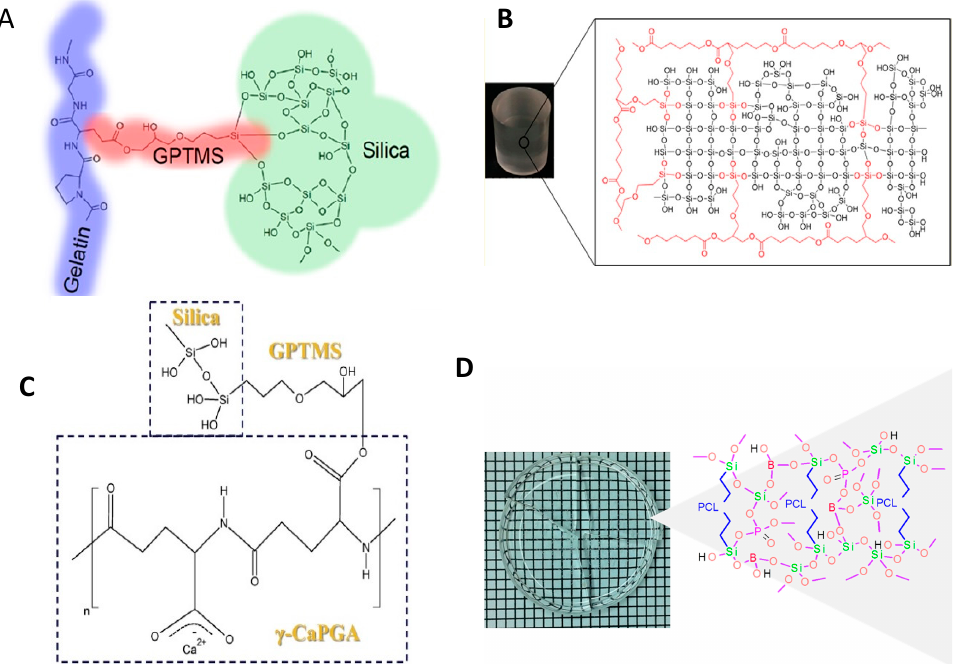
Figure 1. ( A ) Chemical structure of the linkage of organic and inorganic components by (3-glycidoxypropyl) trimethoxysilane (GPTMS) in class II gelatin / silica hybrids [162] ( B ) chemical structure of hybrids of silica and copolymer of caprolactone and glycidoxypropyl trimethoxysilane [163] ( C ) schematic illustration of the expected chemical structure of the calcium-containing silica / γ -PGA hybrid [164] ( D ) digital photo and chemical structure of class II PCL-borophosphosilicate hybrids [78]. Reproduced with permission from the cited